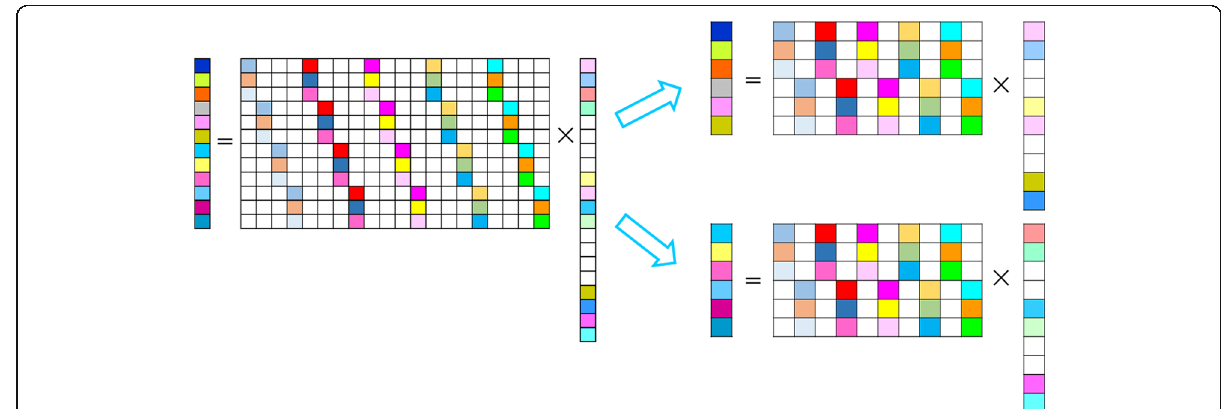
Fig. 2 Dividing a complicated problem into two simple sub-problems, where K = 5, M = 3, N c = 4, and v =